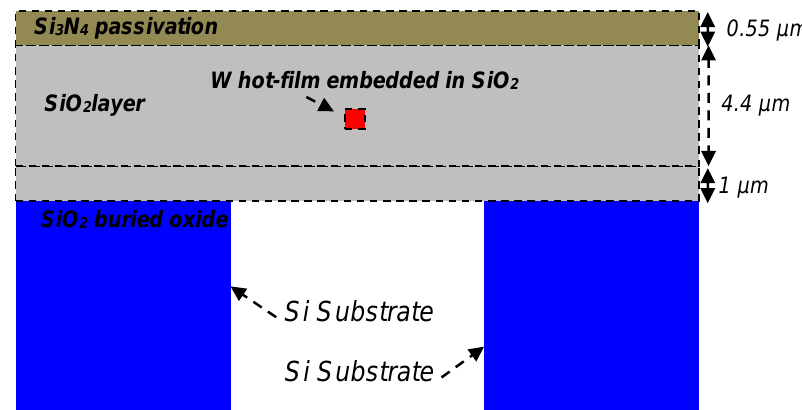
Figure 2. Schematic cross-section (not to the scale) of a tungsten hot-film thermal flow sensor.